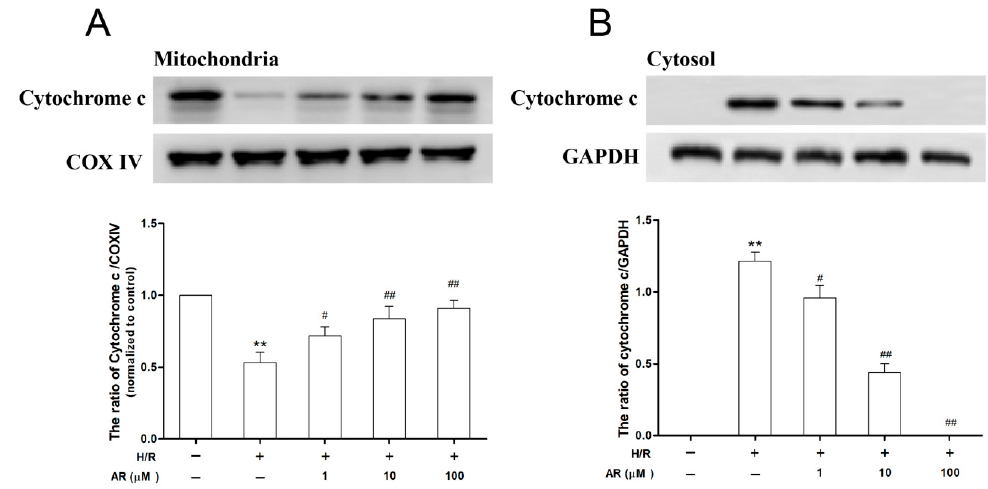
Figure 7. Effects of AR on preventing cytochrome c release in H9c2 cardiomyocytes exposed to H/R. ( A ) The release of cytochrome c in mitochondria; ( B ) Cytosolic translocation of mitochondrial cytochrome c in different experimental groups. Values presented are mean ± S.D ( n = 3). **: p < 0.01 vs. control group; # : p < 0.05 vs. H/R group; ## : p < 0.01 vs. H/R group.